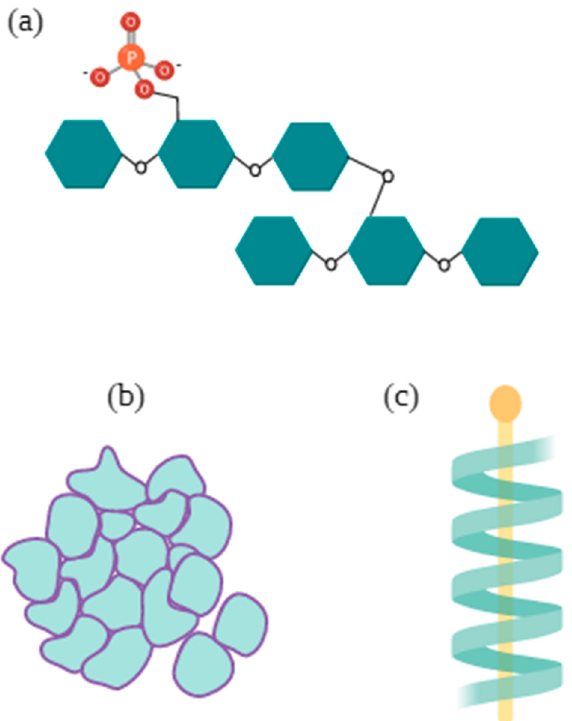
Figure 2. Minor components’ interaction with starch. ( a ) Phosphates bound to C3 or C6 glucose residues portrayed in cyan of amylopectin lateral chains; ( b ) protein matrix around starch granules; ( c ) fatty acid complex with amylose or lateral amylopectin chain helix. Based its use on [47,148,149].